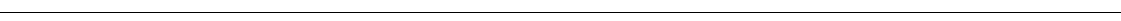
Figure 1 | Gpr176 is an SCN-enriched orphan GPCR that sets the pace of circadian timing. ( a ) The SCN-GPCR project leading to the identification of Gpr176 . The bar graph shows the rank order of expression of the top 100 GPCRs (classes A, B, and C) detected in the SCN microarray analysis (GEO accession number: GSE28574). Red bars are the receptors known to be expressed in the SCN. The horizontal line indicates the threshold of statistical significance of expression. The genes highlighted in blue, which include all listed orphan GPCRs, were characterized further by in situ hybridization using radiolabeled gene-specific probes. Arrows indicate robust positive SCN signals for Gpr176 , Calcr and Gpr19 . ( b ) Snake-plot representation of the mouse Gpr176. The residues highlighted in yellow indicate the DRYxxV motif located at the cytoplasmic end of the transmembrane helix III. ( c ) Northern blotting for Gpr176 with a mouse multiple-tissue blot (Clontech). ( d ) Representative mouse coronal brain section immunolabeled for Gpr176. Scale bar,